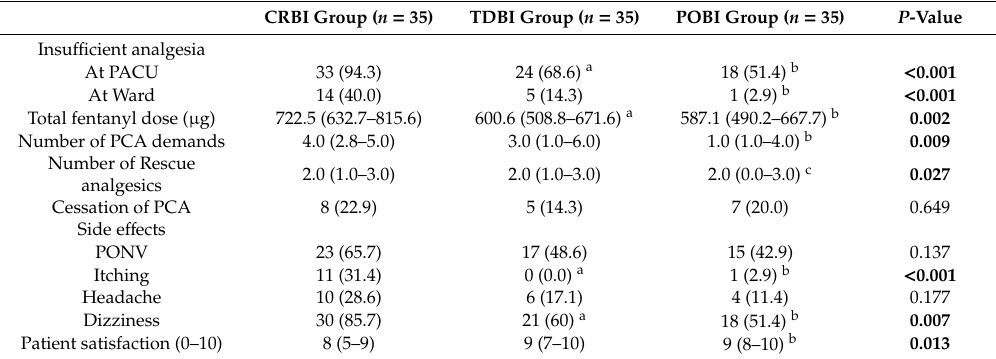
Figure 1. Consort flow diagram of recruitment and assessment of study participants. CRBI group, fentanyl patient-controlled analgesia (PCA) with constant rate background infusion (BI); TDBI group, fentanyl PCA with time-scheduled decremental BI; POBI group, fentanyl PCA with PCA-optimised BI. Table 2. Postoperative analgesic profiles, side e ff ects and patient satisfaction scores after receiving Table 1. Characteristics of patients receiving post-operative anaesthesia, and duration of surgery and post-operative anaesthesia. Data are represented as number (%), or median (interquartile range). anaesthesia. Data are represented as mean ± standard deviation. CRBI Group ( n = 35) TDBI Group ( n =